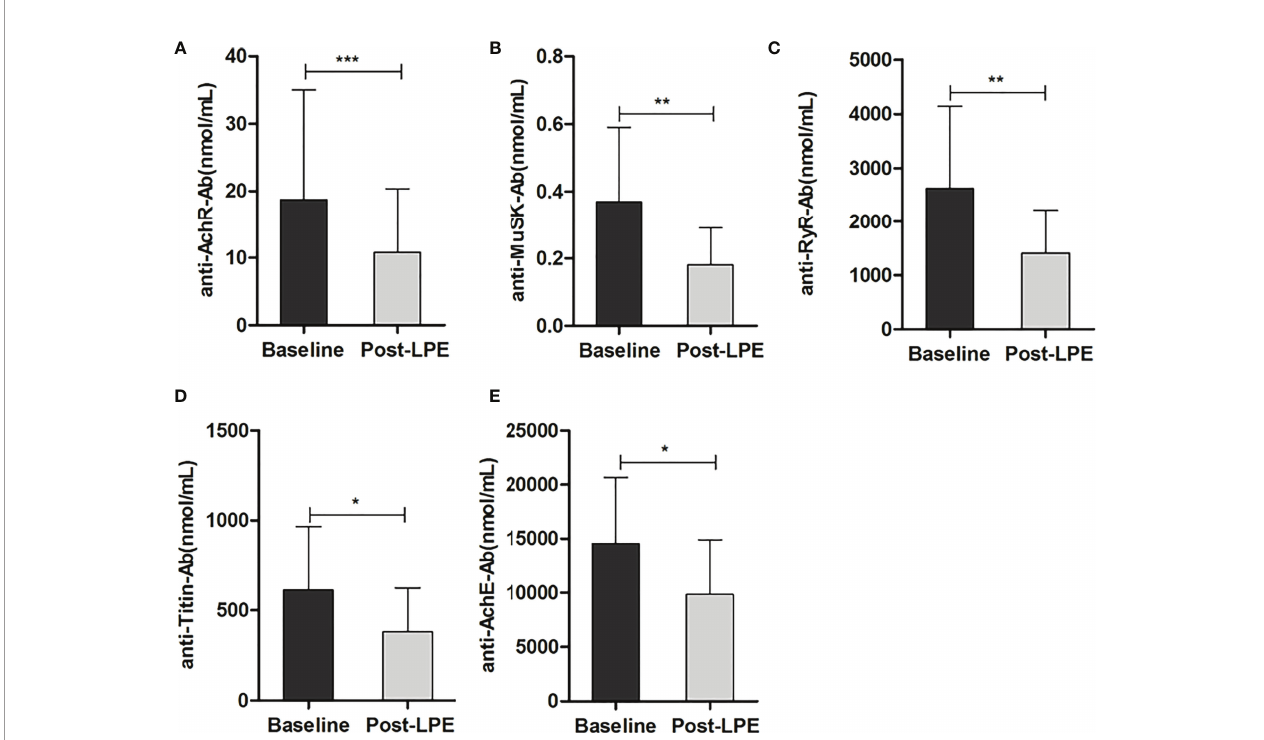
FIGURE 3 | LPE reduced serum levels of autoantibodies after LPE therapy. (A) Effect of LPE on the anti-AchR antibody (n = 248). (B) Effect of LPE on anti-MusK antibody (n = 18). (C) Effect of LPE on the anti-RyR antibody (n = 21). (D) Effect of LPE on anti-Titin antibody(n = 26). (E) Effect of LPE on anti-AchE antibody (n = 25) (*p < 0.05, **p < 0.01, ***p < 0.001).LPE, lymphoplasma exchange; AchR Ab, acetylcholine receptor antibody; AchE Ab, acetylcholinesterase antibody; Musk Ab, anti-muscle-speci fi c kinase antibody; RyR Ab, anti-ryanodine receptor; MG, myasthenia